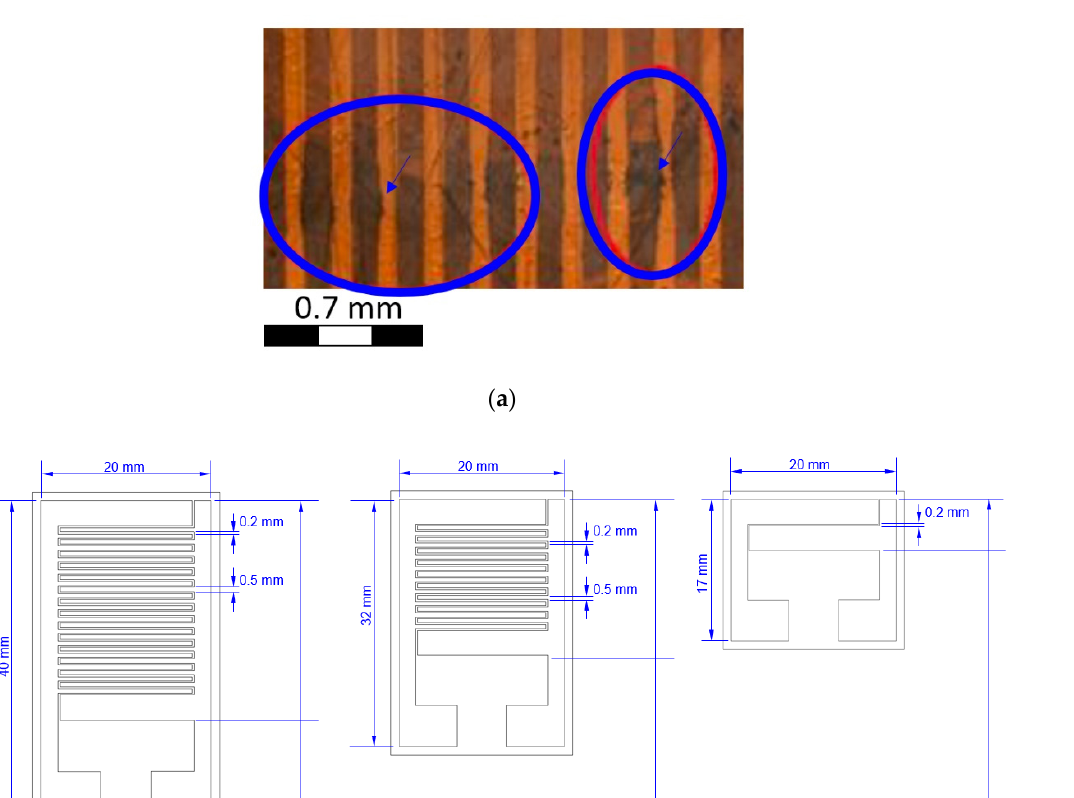
Figure 7. The screen printing process.